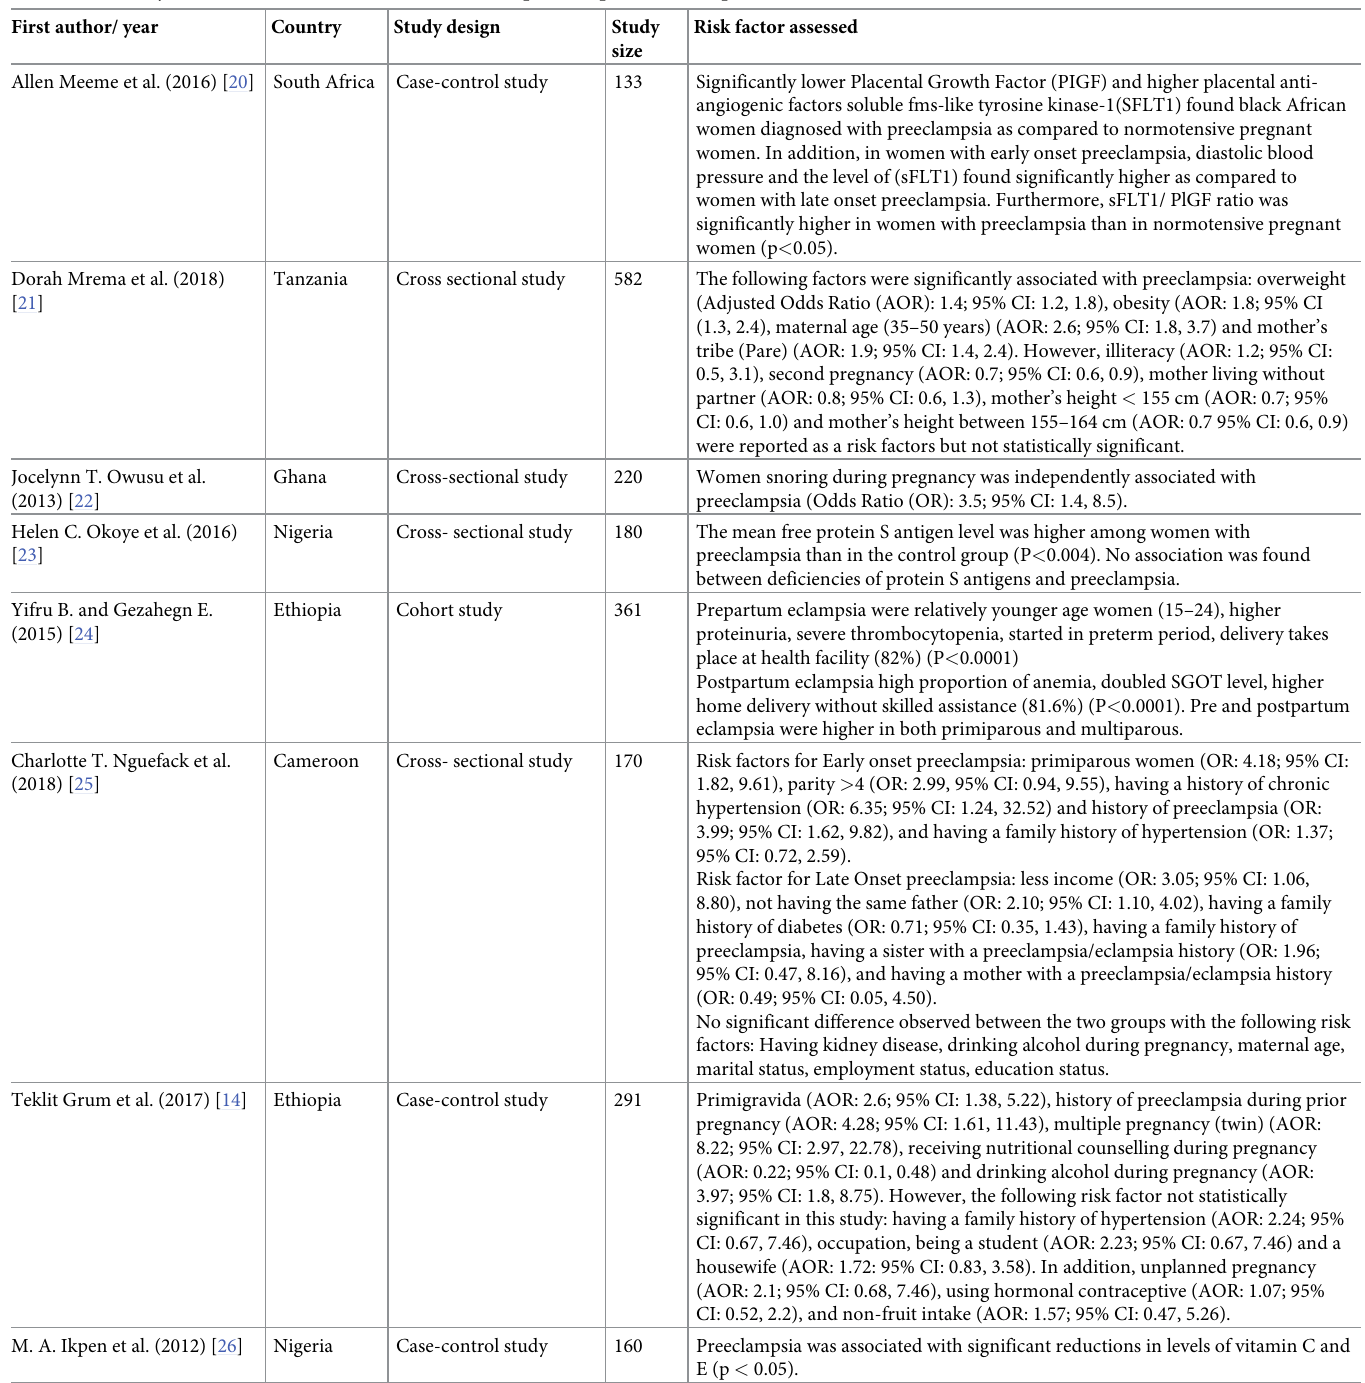
Table 1. Summary table of studies included in risk factors for preeclampsia and eclampsia in SSA